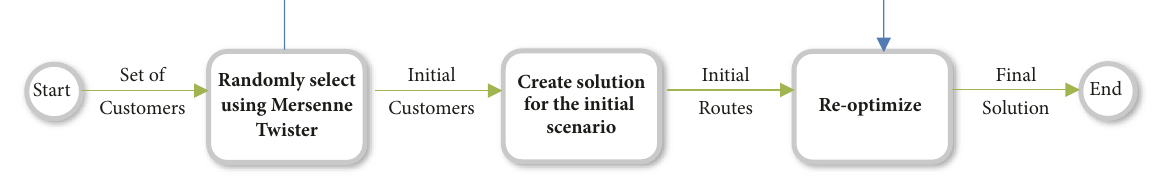
Figure 1: Experimental layout.